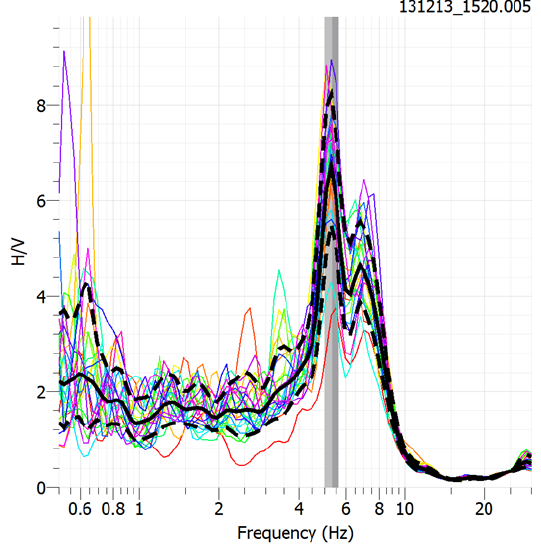
Figure 10. The 28 April 2013, 16:33UMT time seismic event at 37.45 (latitude) 22.70 (longitude) 58.0km (depth) by EMSC